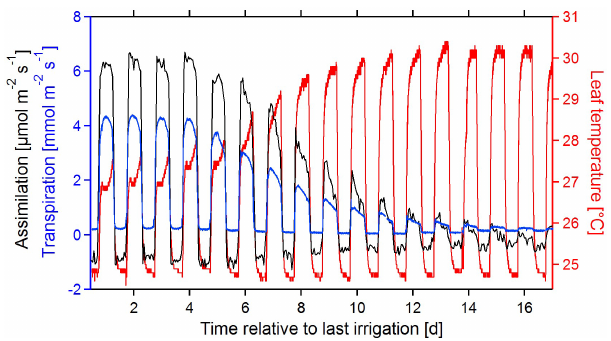
Figure 1. Temporal development of transpiration (blue trace, left hand y axis) and leaf temperature (red trace, right hand y axis, aver- age of three leaves) at the example of Holm oak, experiment 1. The plant was irrigated at day 0 ( (cid:50) = 0 . 4m 3 × m − 3 ). At the end of the drought period (cid:50) had fallen to 0.05m 3 × m − 3 . Chamber tempera- ture 25 ◦ C, PAR = 600µmolm − 2 s − 1